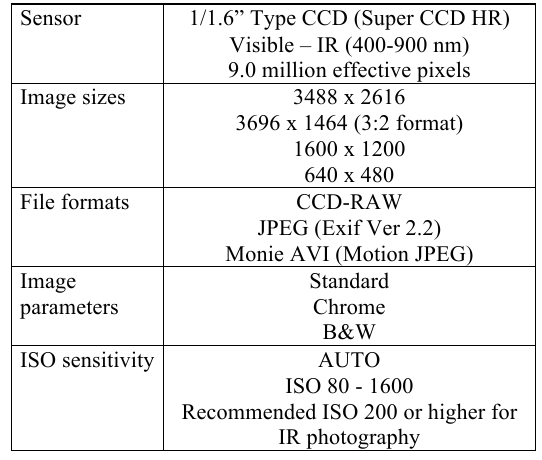
Table 1. Digital Camera IS-1 main